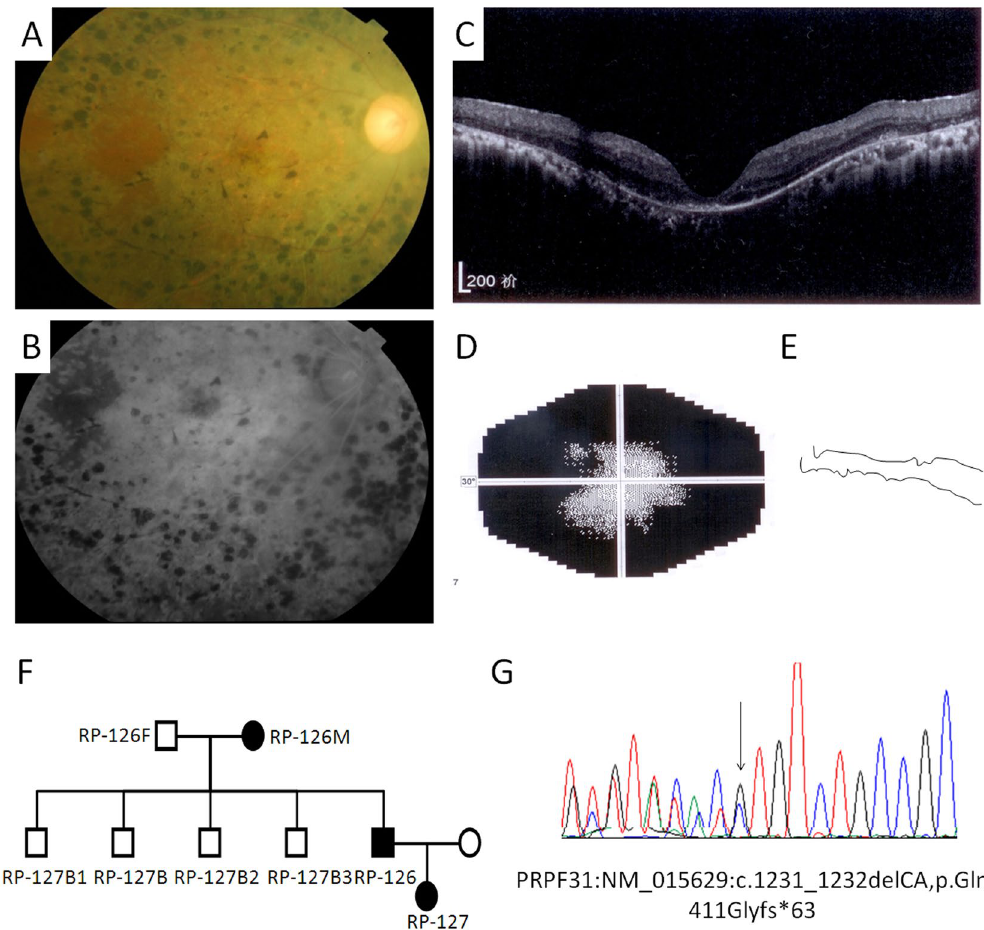
Figure 2. The phenotypes and mutation of patient RP-126 who carries a heterozygous mutation in the PRPF31 gene. ( A , B ) Color fundus photograph ( A ) and while and black fundus photograph ( B ) of patient RP-126 shows a prominent multilobulated central atrophic maculopathy surrounded by concentric rings of black deposits. ( C ) Optical coherence tomography images of patient RP-126. ( D ) Vision field diagram of patient RP-126 shows the obvious vision loss (Humphrey automated threshold perimetry, Program 30-2). ( E ) ERG recording of A and B waves of patient RP-126 (30 µ V/D, 25 ms/D). ( F ) Pedigree of RP-126 family. ( G ) The Sanger sequencing tracing of the mutation detected in the RP-126 family ( PRPF31 : NM_015629:c.1231_1232delCA, p.Gln411Glyfs *